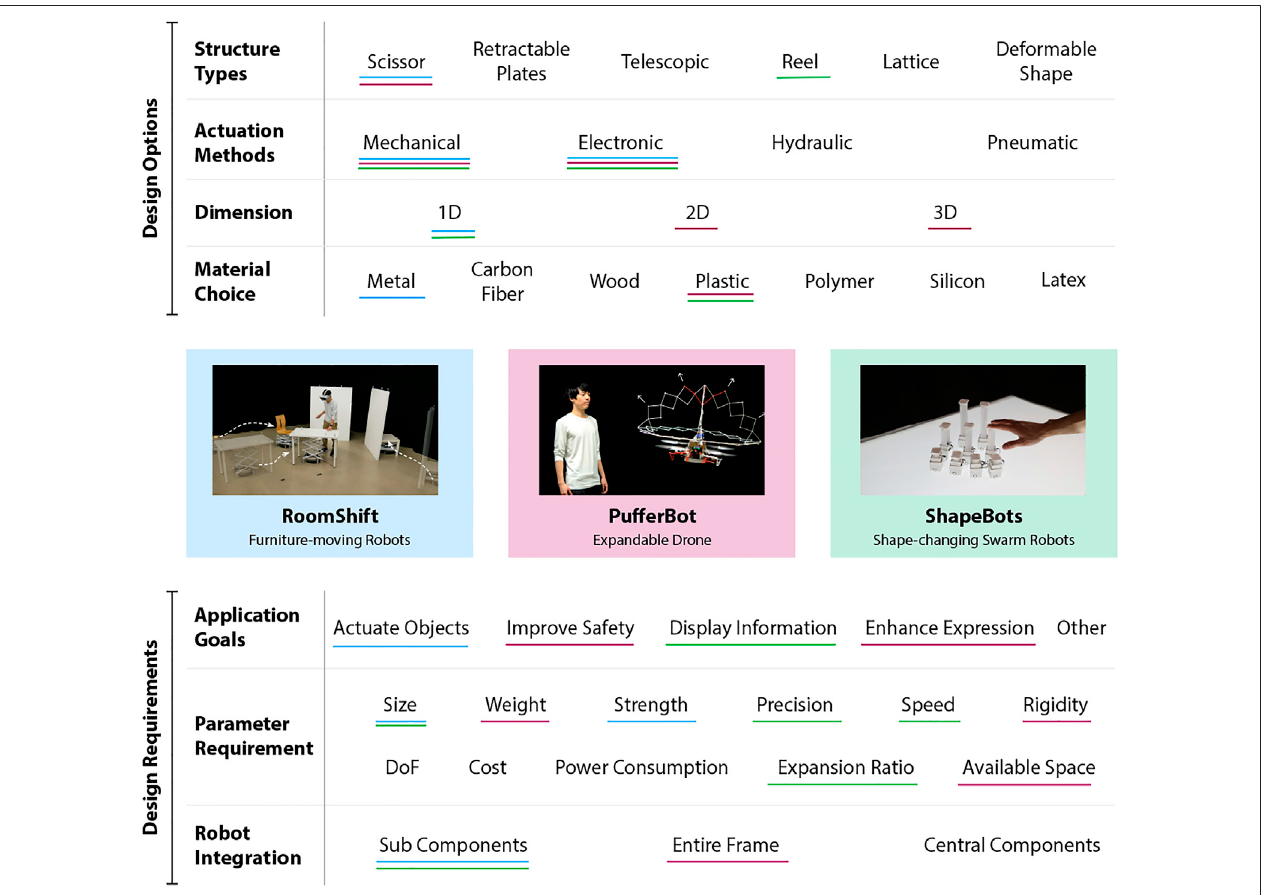
FIGURE 16 | Above, we synthesize the major implementation and interaction considerations for designing expandable structures for HRI. We also highlight the choices made in each of our three case studies.